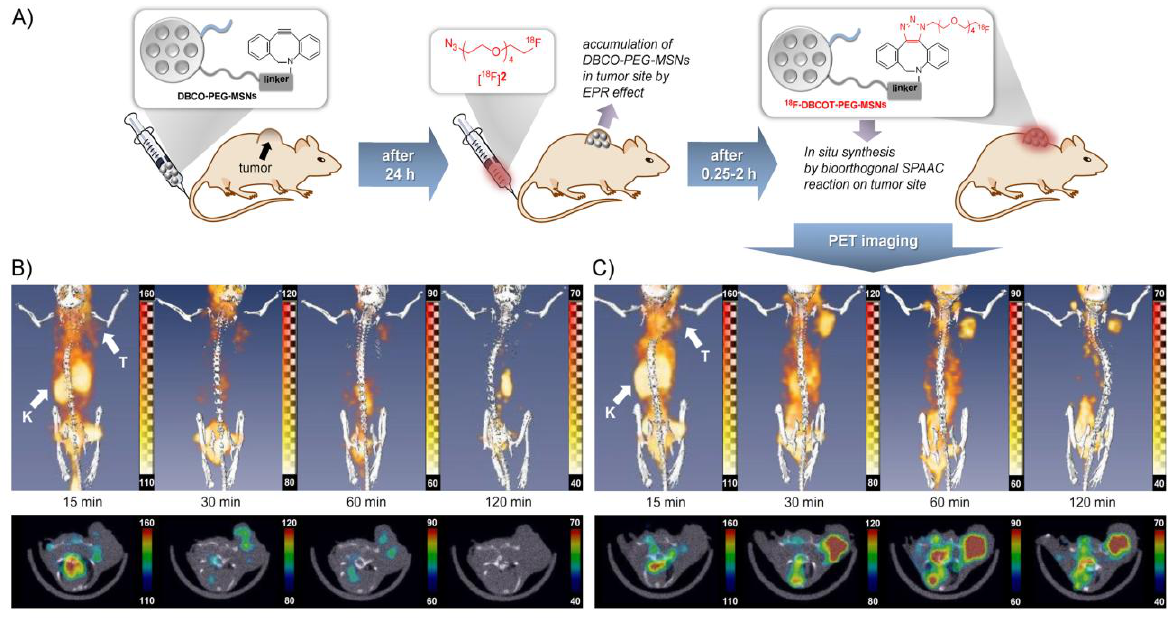
Figure 4. ( A ) Pre-targeting/labeling protocol for in vivo click reaction. ( B ) 3D PET images (upper row) and transversal slides (lower row) of a U87 MG tumor-bearing mouse injected with ω-[ 18 F]fluoro-pentaethylene glycolic azide without pretargeting. ( C ) 3D PET images ( upper row ) and transversal slides ( lower row ) of a U87 MG tumor-bearing mouse injected with ω-[ 18 F]fluoro-pentaethylene glycolic azide with pretargeting using DBCO-PEG-NPs. Reprinted with permission from S.B. Lee et al. [22]; Copyright 2013 John Wiley and